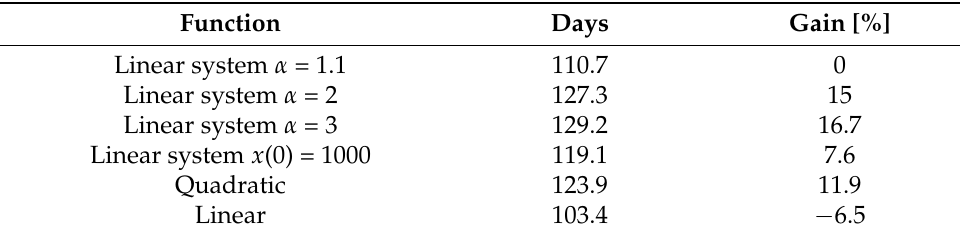
Table 5. Wait function